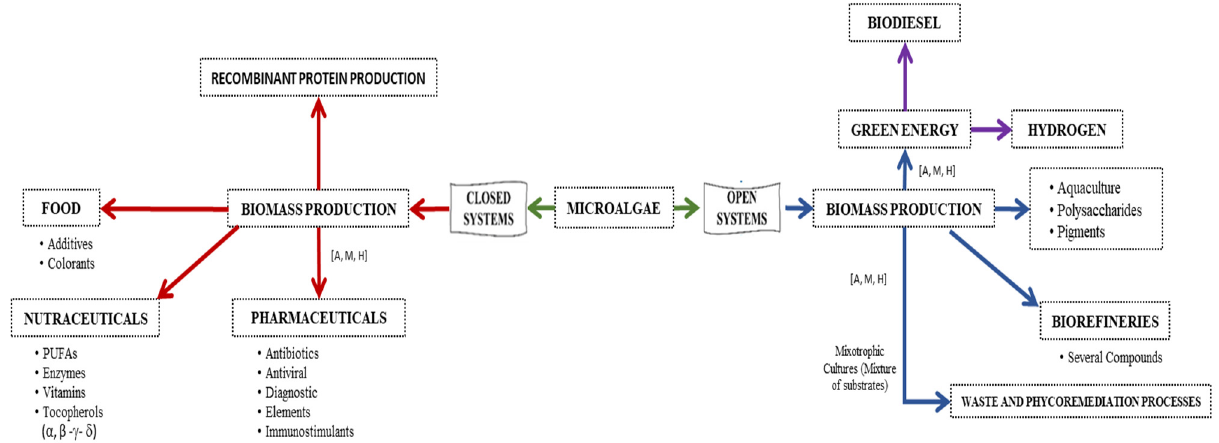
Figure 3. Biotechnology integration process for responsible production and consumption. Process integration in both open and closed systems.